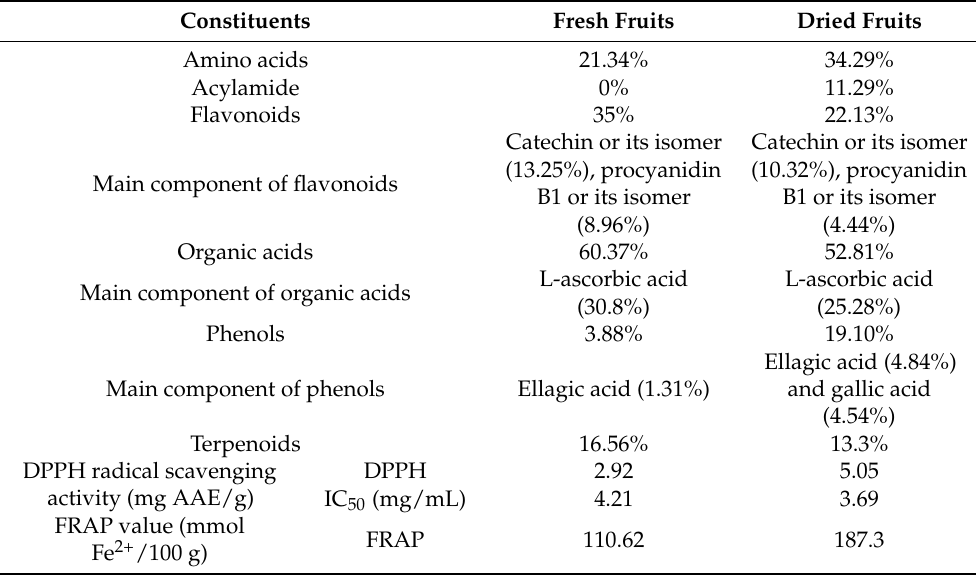
Table 6. Comparison of constituents and in vitro antioxidant activities of fresh and dried. R. roxburghii fruits